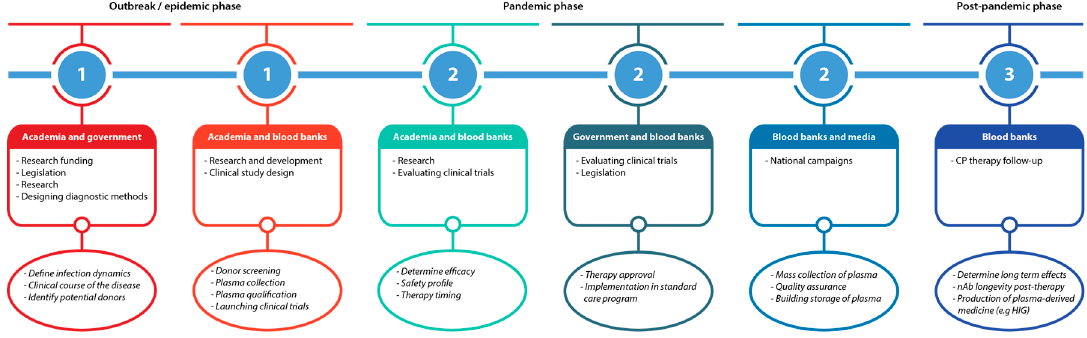
Figure 2. Flowchart of the pandemic preparedness